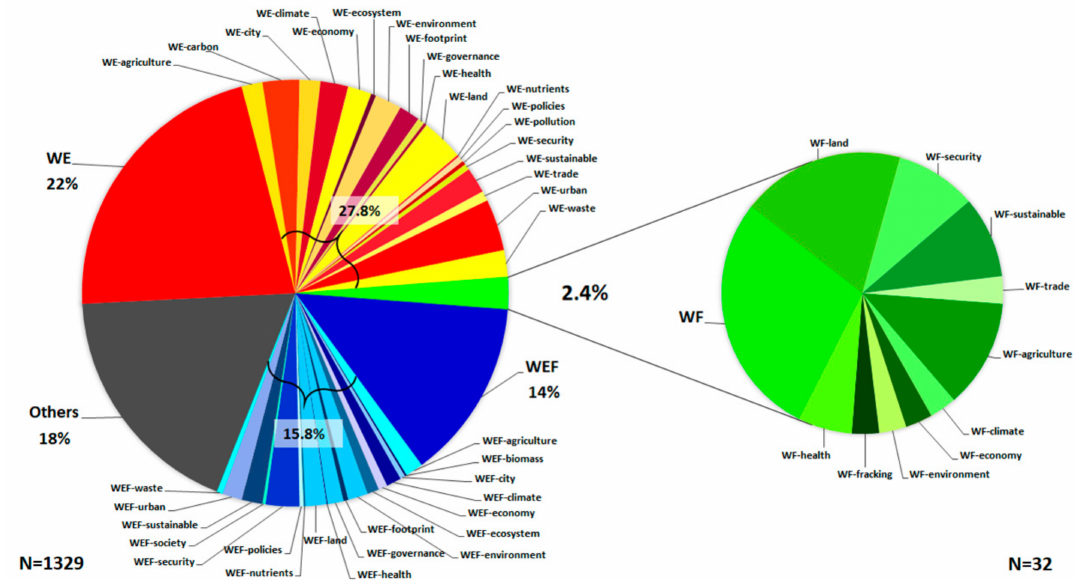
Figure 2. Published documents about Water–Energy–Food (WEF), Water–Energy (WE), Water–Food (WF), and others. SCOPUS analysis in